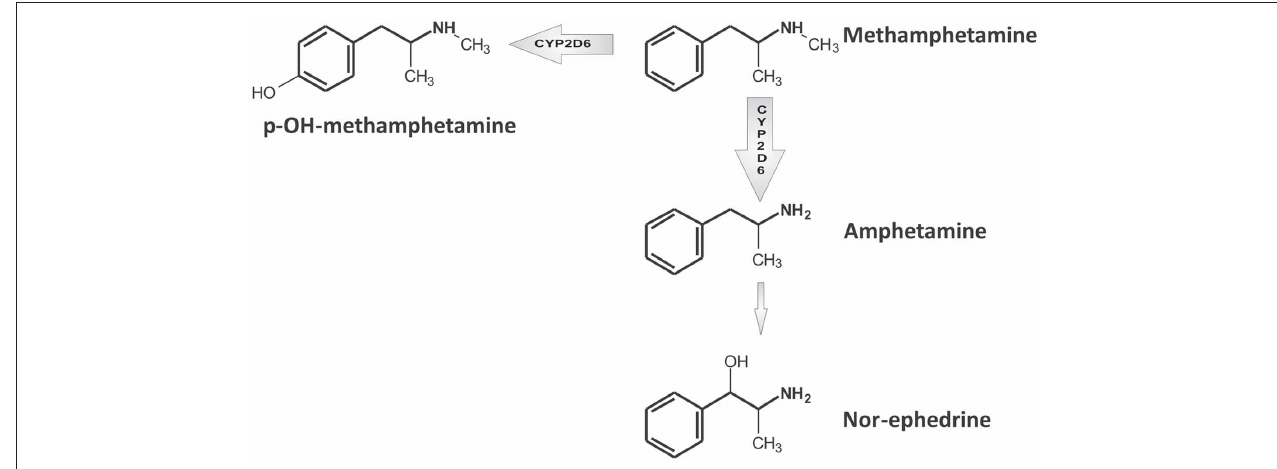
FIGURE 2 | Simplified scheme of methamphetaminemain metabolic pathways. For a more detailed description, readers are referred to Shima et al.